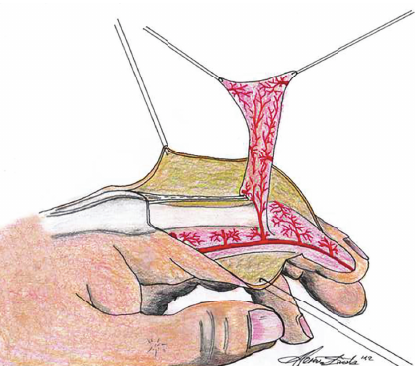
Figure 2: Design of the adipofascial flap describing its vasculariza- tion. The interruption of the ulnar flow allows for rotation of the flap on the defect (located at the radial side), maintaining its